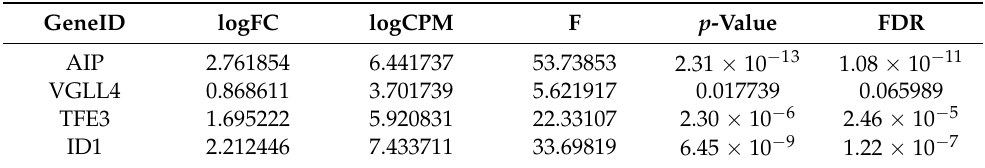
Table 4. Differentially expression of AIP, VGLL4, TFE3, and ID1 in response to genistein in HepG2 cell line.